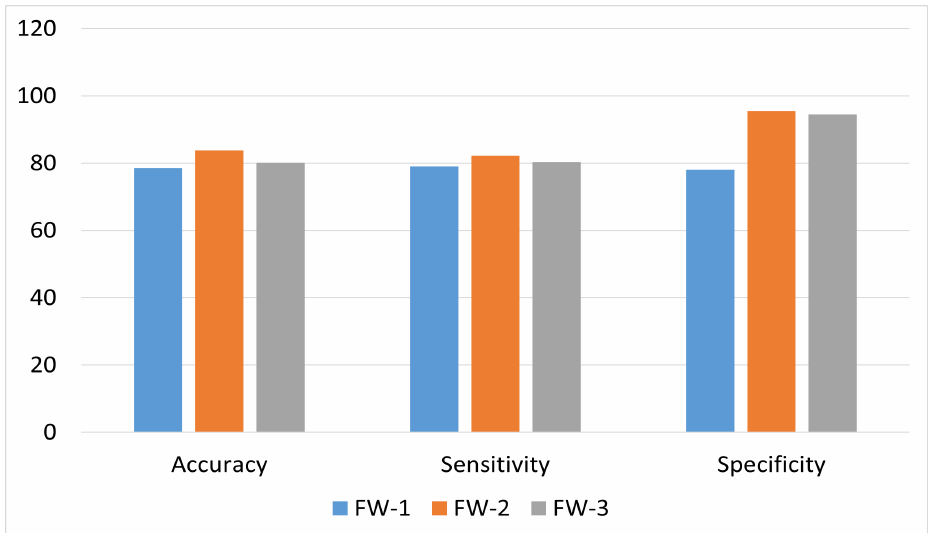
Figure 8. Performance comparison of all three proposed frameworks using augmented